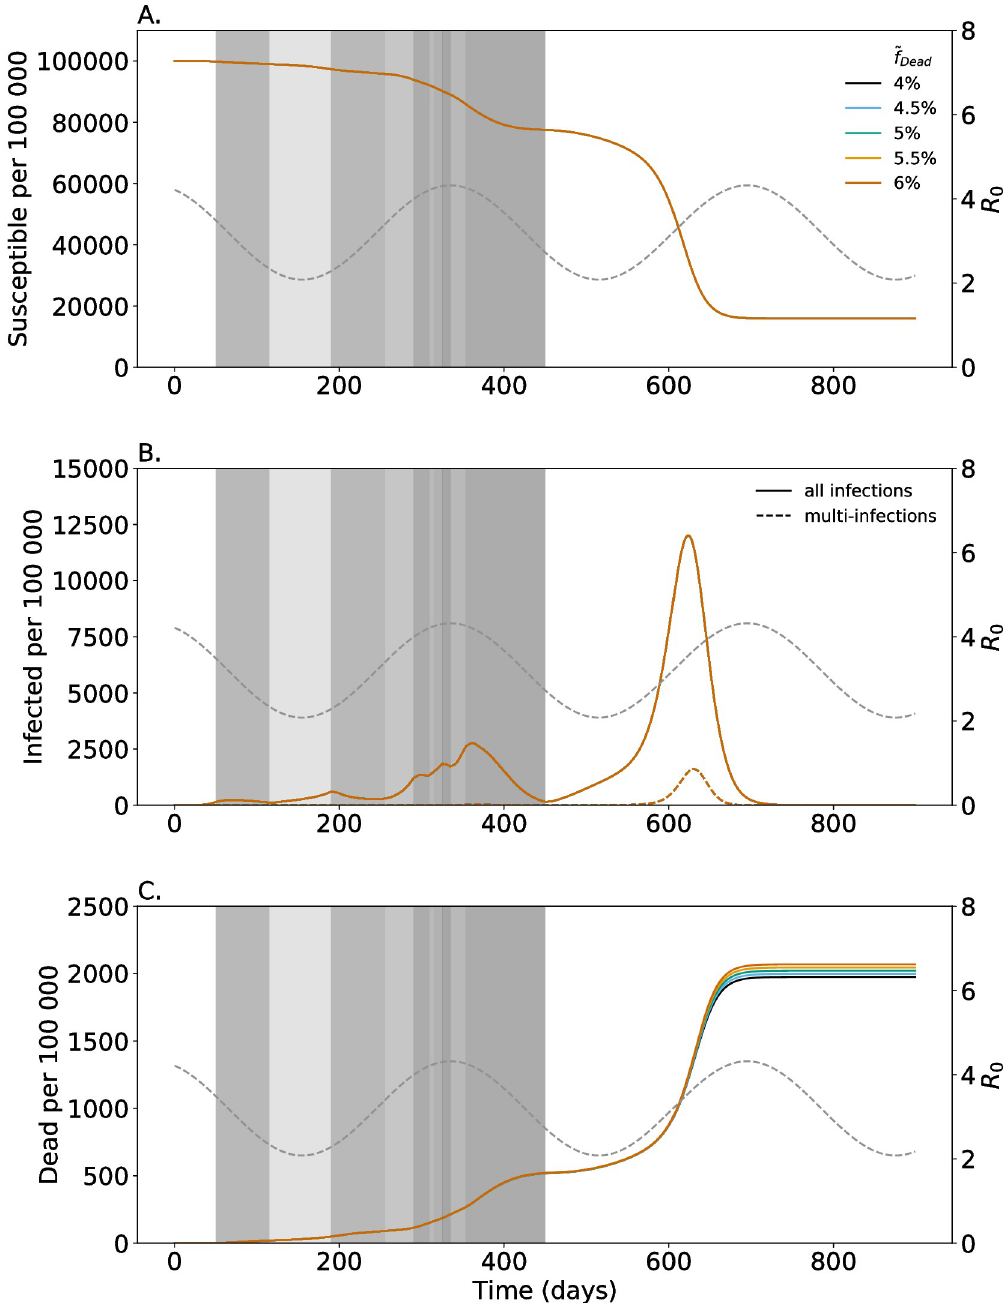
Fig 4. Increased mortality of symptomatic multi-infections. As in Fig 2 but for different values of increased mortality ( ~ f of symptomatic multi-infected individuals (colors).